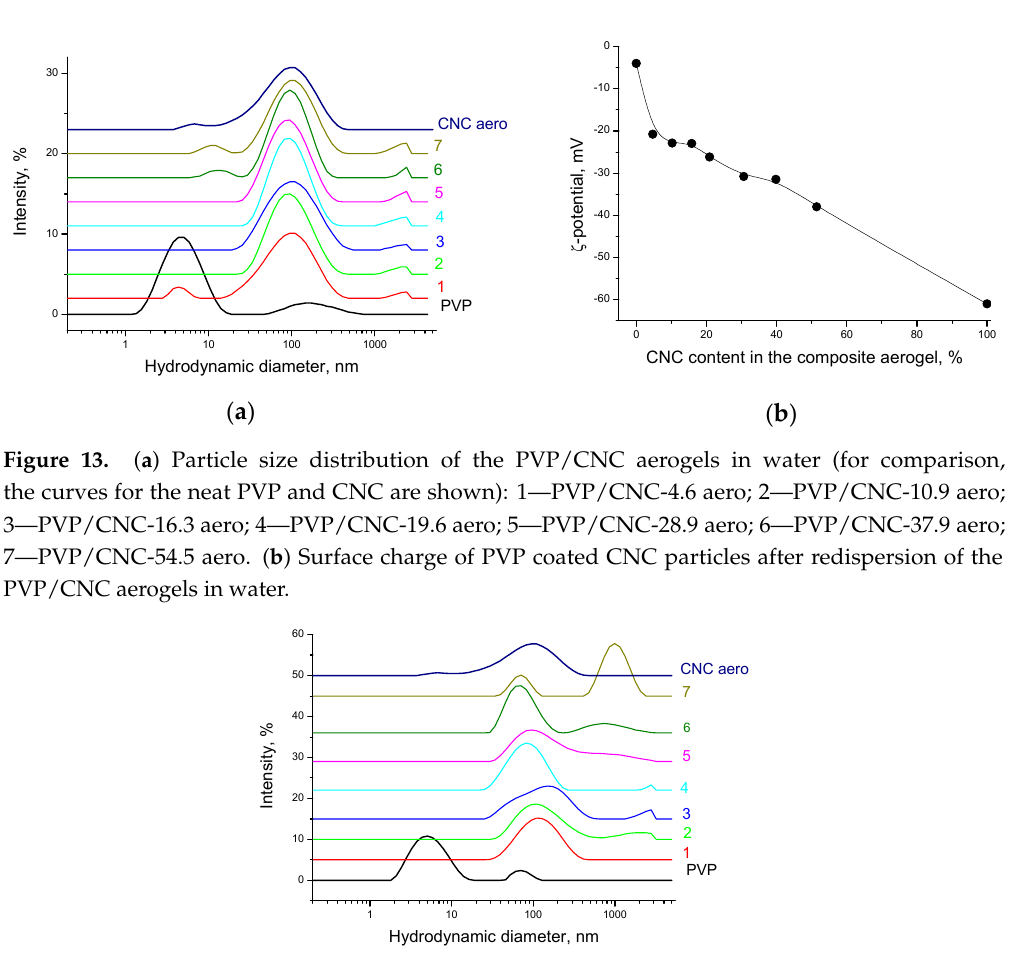
Figure 14. Particle size distribution of the PVP/CNC aerogels in propanol (for comparison, the curves for the neat PVP and CNC are shown): 1 - PVP/CNC-4.6 aero; 2 - PVP/CNC-10.9 aero; 3 - PVP/CNC-16.3 aero; 4 - PVP/CNC-19.6 aero; 5 - PVP/CNC-28.9 aero; 6 - PVP/CNC-37.9 aero; 7 - PVP/CNC-54.5 aero.